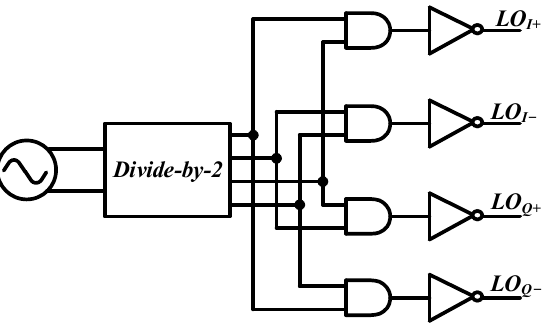
Figure 5. The 25% duty-cycle clock generation using a frequency divider and AND gates.